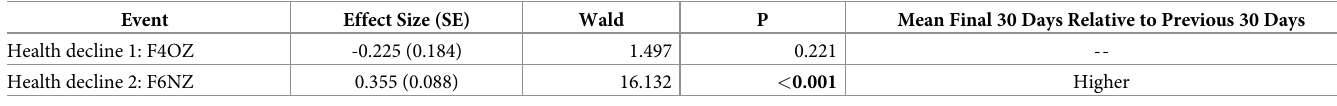
Table 8. Health decline leading to euthanasia as a predictor of adrenal GC activity. Fixed effects, effect size with standard error (SE), Wald statistic, and p-value from GLMMs, and whether the mean cortisol concentration in the final 30 days before death was higher or lower than the previous 30 days. Degrees of freedom (df) is 1 in all pair-wise